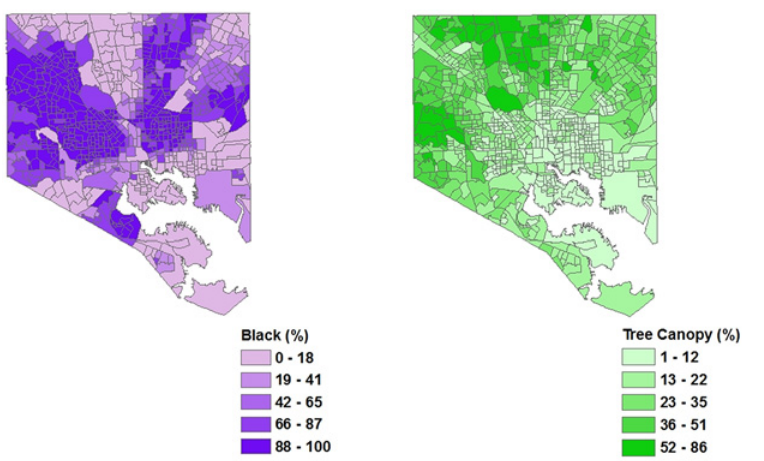
Fig 2. A spatially-explicit map depicting the percent of the population that self-identifies as black (left panel) and the percent of UTC cover for Baltimore, MD (right